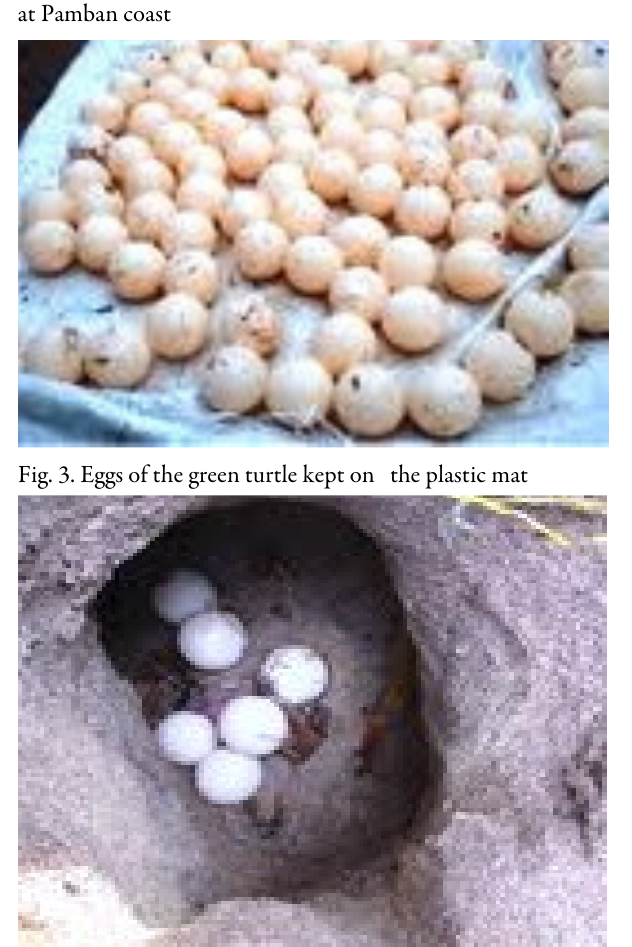
Fig. 4. Nesting pit of the green turtle observed at Pamban